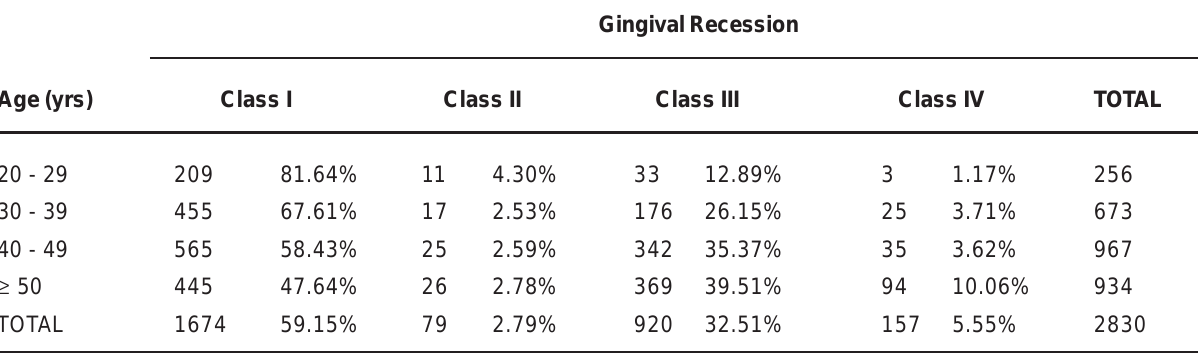
TABLE 2 - Scoring of the severity of gingival recession according to the parameters of